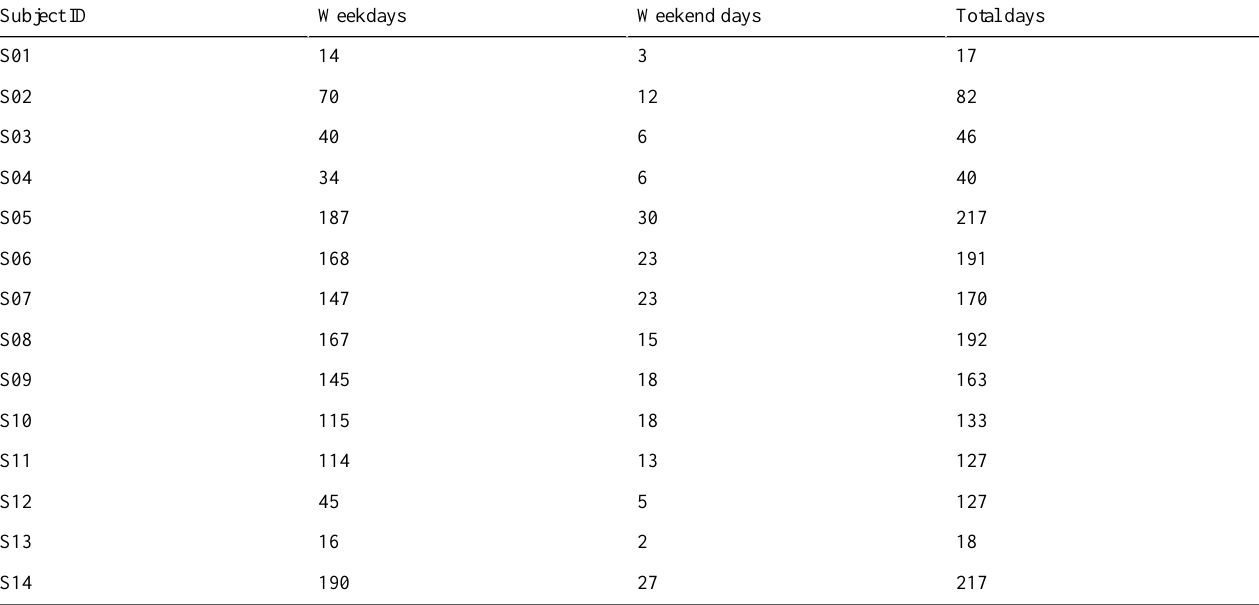
Table 1. Number of participation days (S01-04: working mothers; S05-S14: